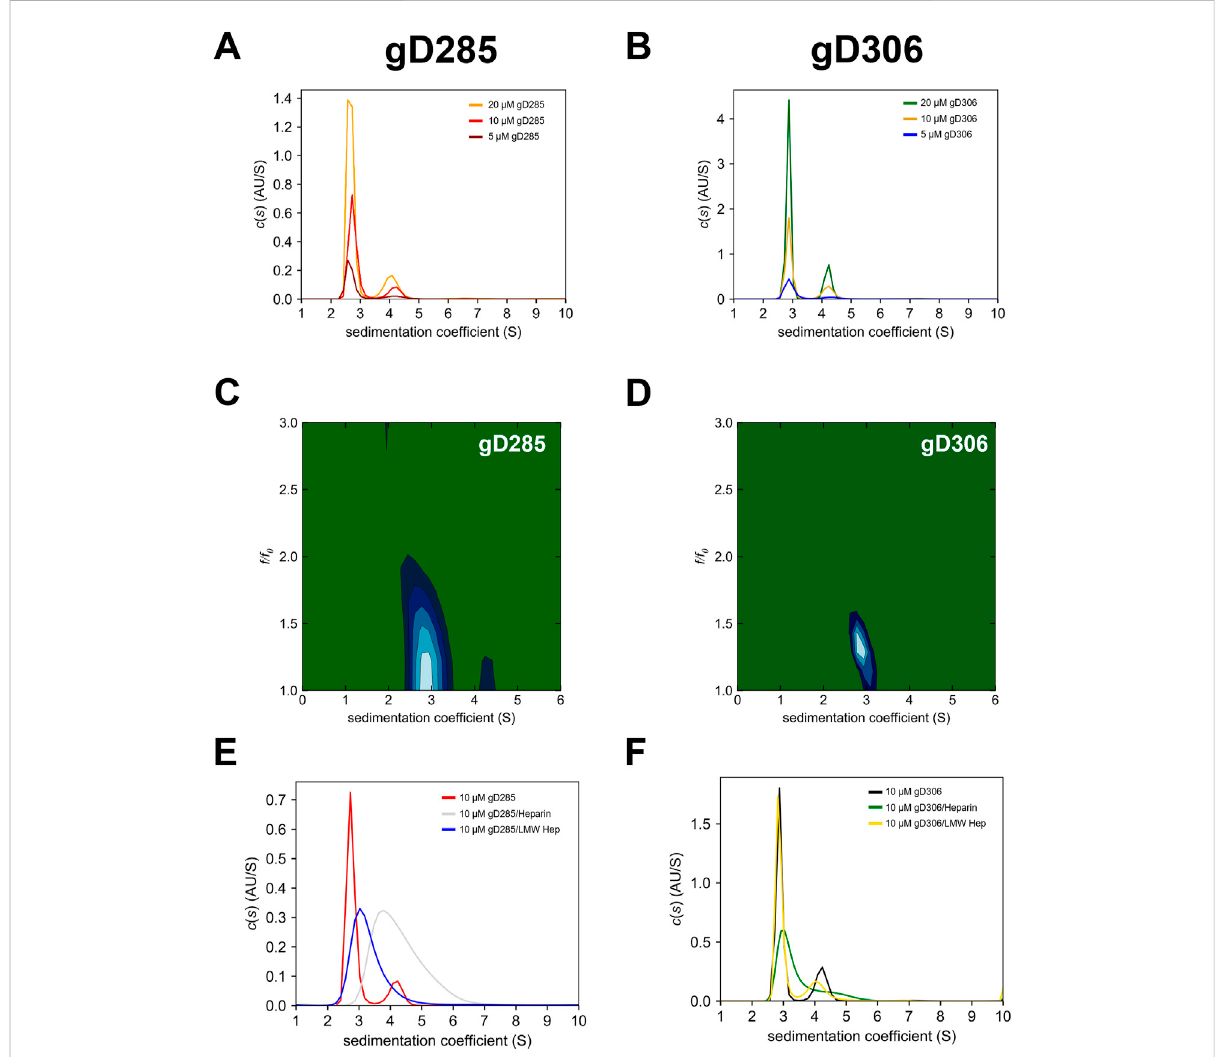
FIGURE 3 2D SV-AUC differentiates the “ open ” gD285 with “ closed ” gD306 that cannot be seen in 1D plots, while the difference in binding af fi nity is evident by gD ’ s selective glycan complex formation. Sedimentation coef fi cient [c(s)] distribution analyses for (A) gD285 and (B) gD306 at 5, 10, and 20 µM. The c(s) analysis shows two distinct species, one with a sedimentation coef fi cient (s) of ~2.7 and another with 4 – 4.2 s-values. Based on correlation with SDS-PAGE and MALDI-TOF-MS, this was concluded to be the monomeric (2.7/2.9 s) and dimeric (4 – 4.3 s) gD species. However, this is not an equilibrium-based dimer, as no there was no shift in the percentage of overall signal from monomer to dimer species proportional to concentration, but an inactive dimeric gD species that does not bind to receptors (unpublished data). Two-dimensional analysis of SV-AUC data with plots of sedimentation coef fi cient (S) versus frictional ratio f/f 0 for (C) gD285 apo and (D) gD306 apo. Sedimentation coef fi cient distributions of (E) 10 µM gD285 or (F) gD306 by itself, with heparin and with low-molecular-weight heparin (LMW) at a 1:1 ratio. gD285 showed distinct complex formation with heparin and LMW heparin, but gD306 only formed a weaker complex with